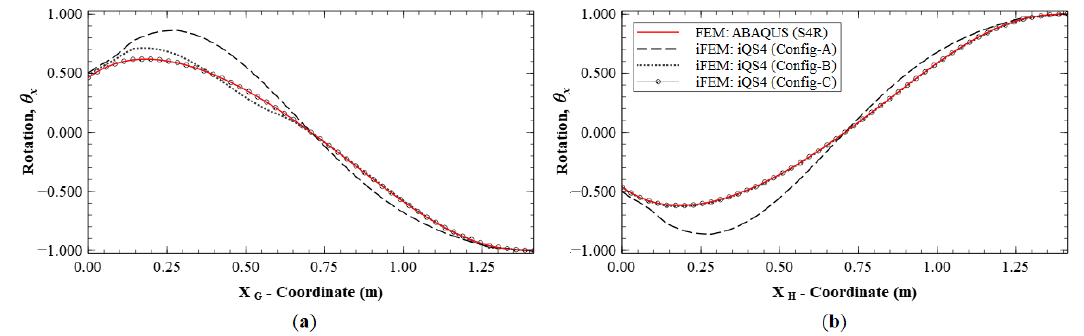
Figure 17. Line plots of rotation ( 𝜃 𝑥 ) for Mode 6 along: ( a ) section G-G’; and ( b ) section H-H’.